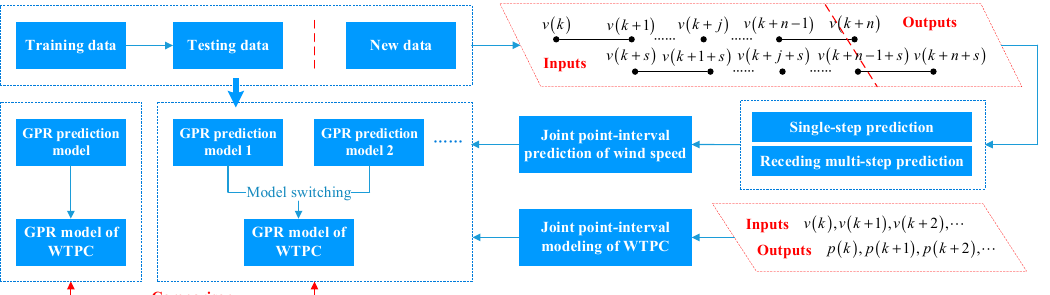
Figure 2. Diagram of joint point-interval prediction of wind power via stepwise procedure.